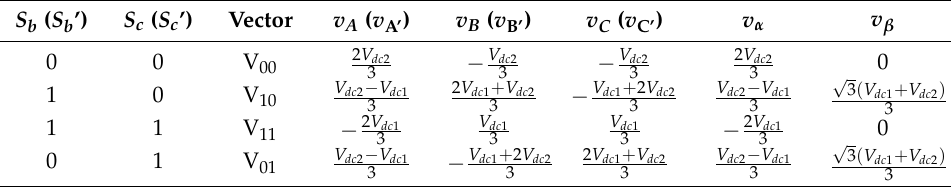
Table 2. Three-phase AC voltages of the FSTP